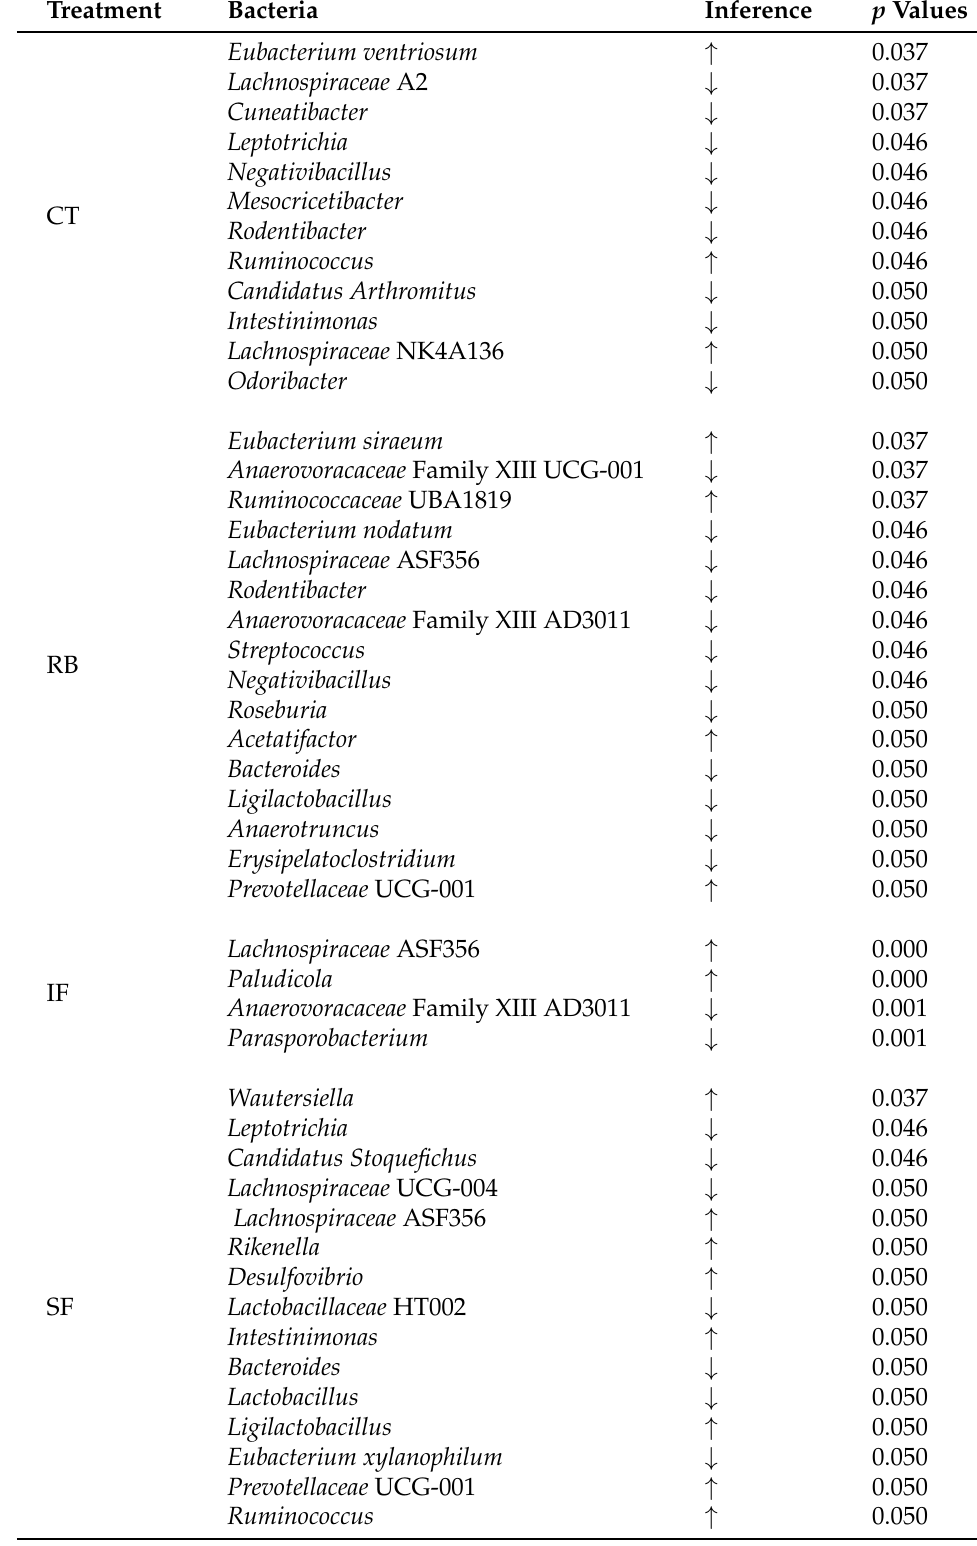
Table 2. Changes in gut bacteria in mice after 30 days of treatment with different fractions of the beverage. Upward arrows indicate increase after 30 days of treatment and vice